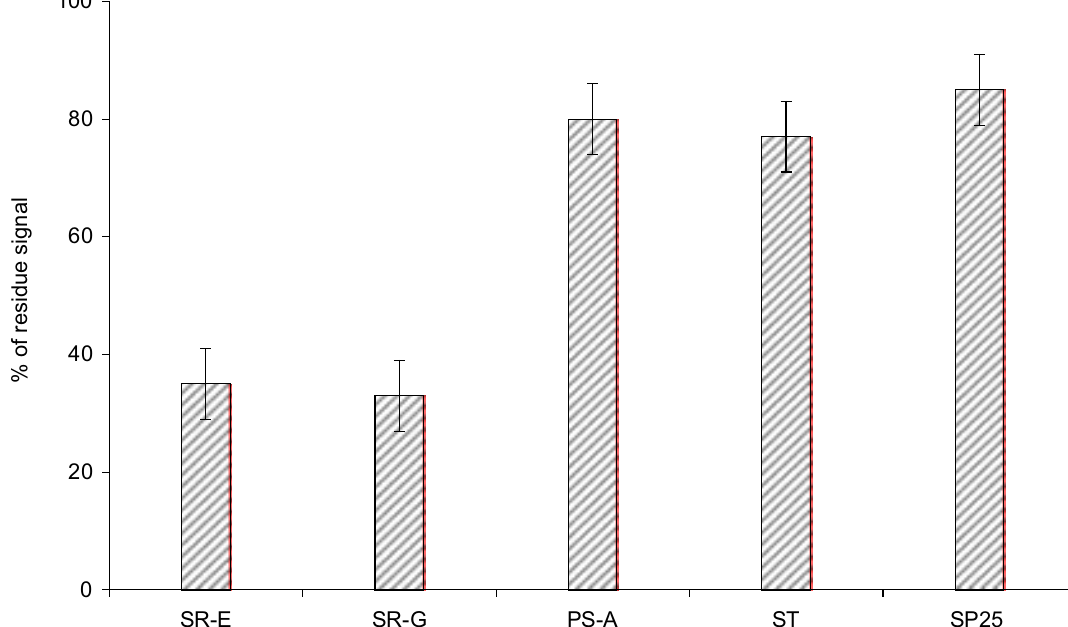
replications.Fig. 1. Specificity of SR-antibodies. Competitive ELISA using anti–SR-E antiserum diluted to1:200 and 1 µ g per well of various Pseudomonas LDP. Analysis of each sample was performed in